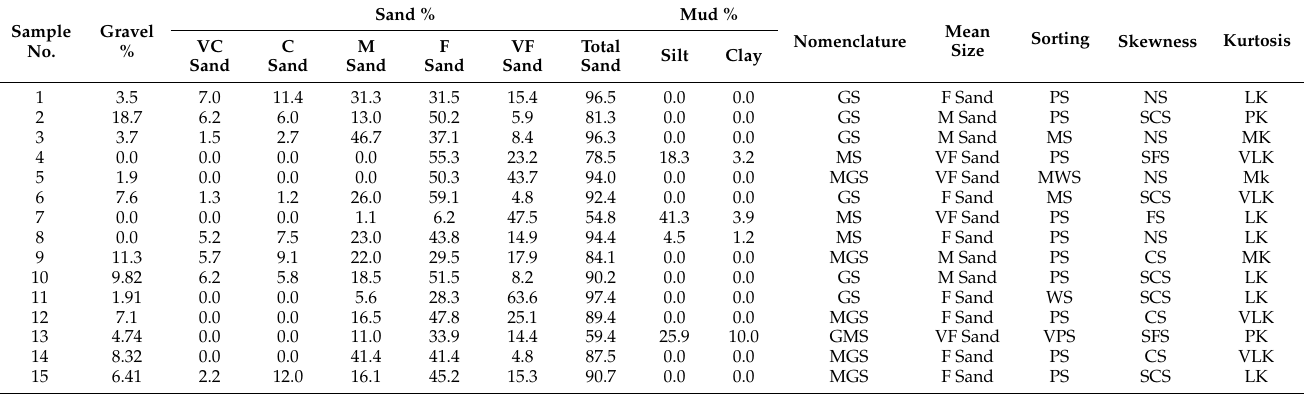
Table 2. Grain size data, textural nomenclature, and Statistical grain size parameters of the studied